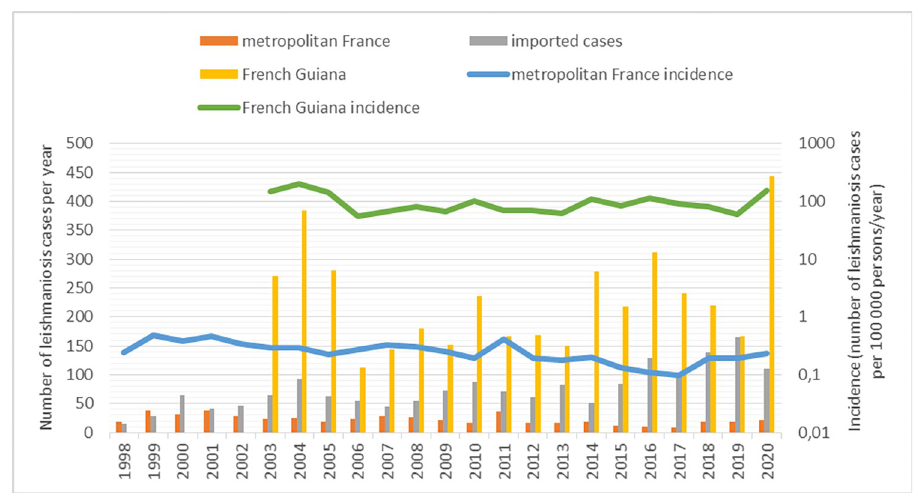
Fig 1. Number of reported cases to the French National Reference Centre for Leishmaniasis by year.